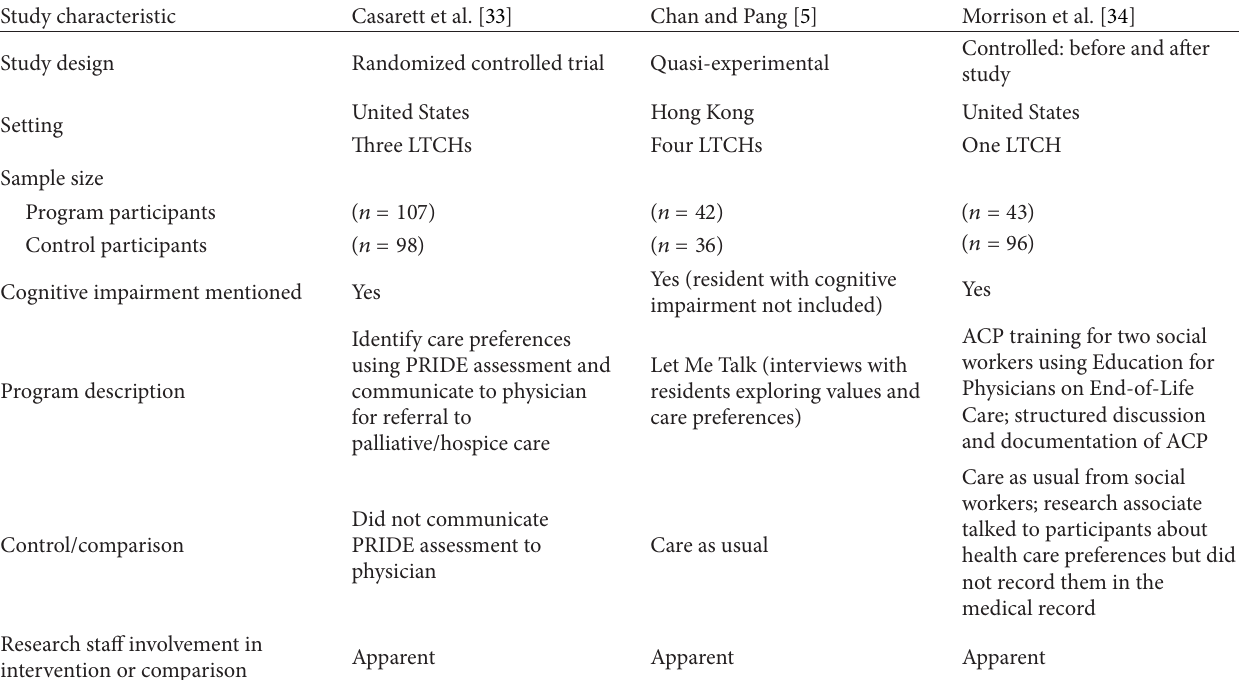
Table 1: Characteristics of the evaluated studies.